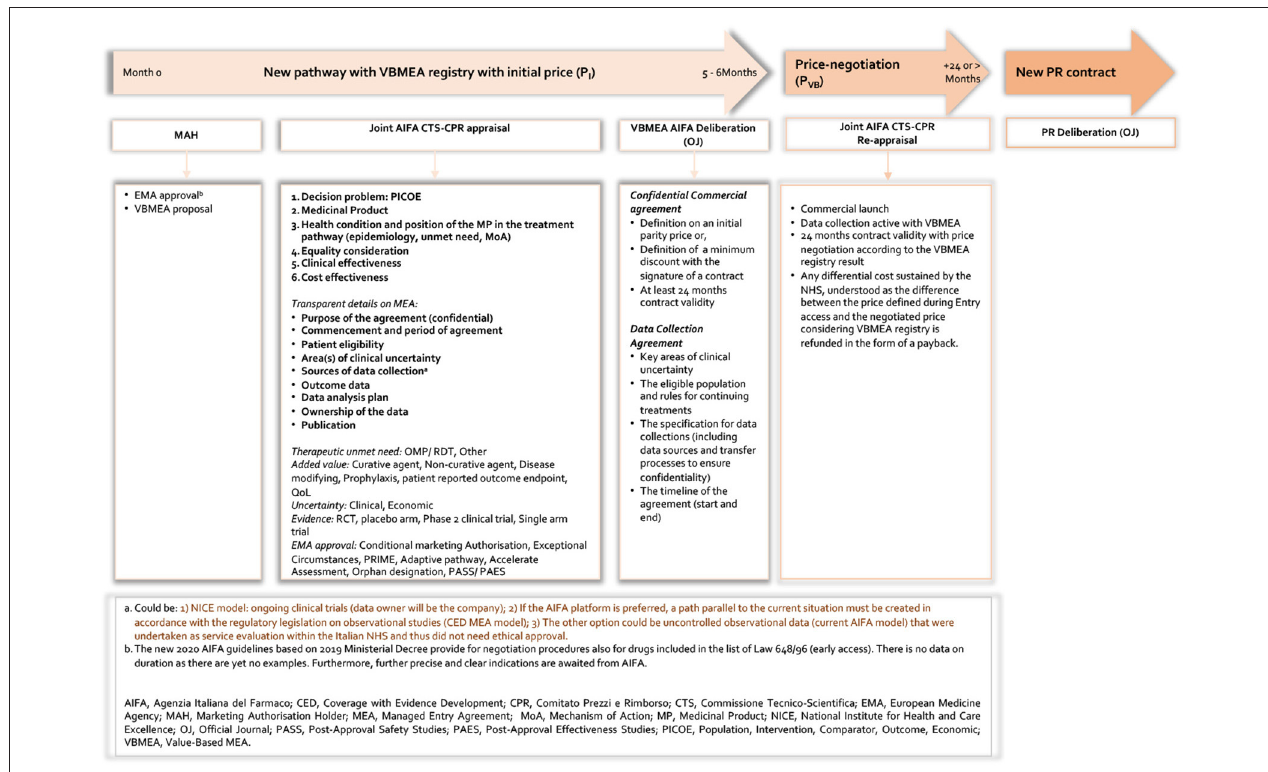
FIGURE 4 | New pathway based on VBMEA AIFA